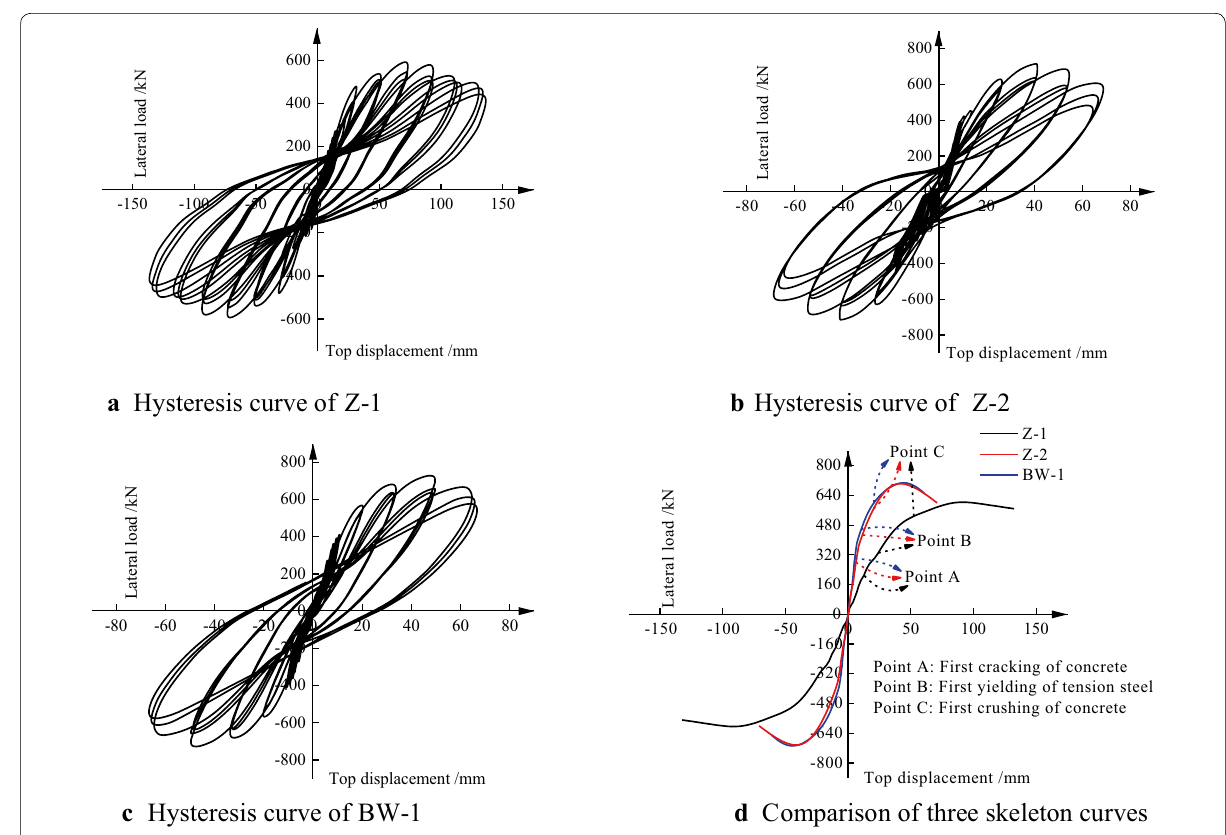
Fig. 7 Load‑displacement curves of three specimens.